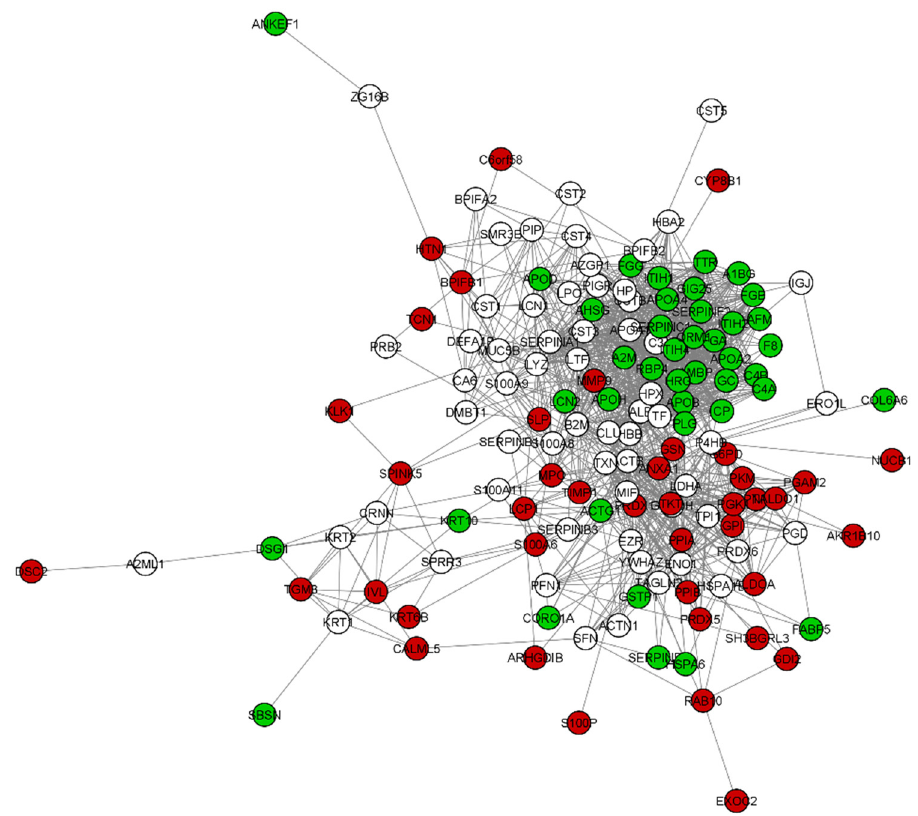
Figure 3: DyNet visualization of union gene/protein networks identi fi ed by FASP digestion strategies: protocol C only ( Amicon 0.5 mL centrifugal fi lter units with MWCO of 30 kDa ) ‒ green circles, only protocol D1 ( Microcon 0.5 mL centrifugal fi lter units with MWCO of 30 kDa ) ‒ red circles, both samples ‒ white